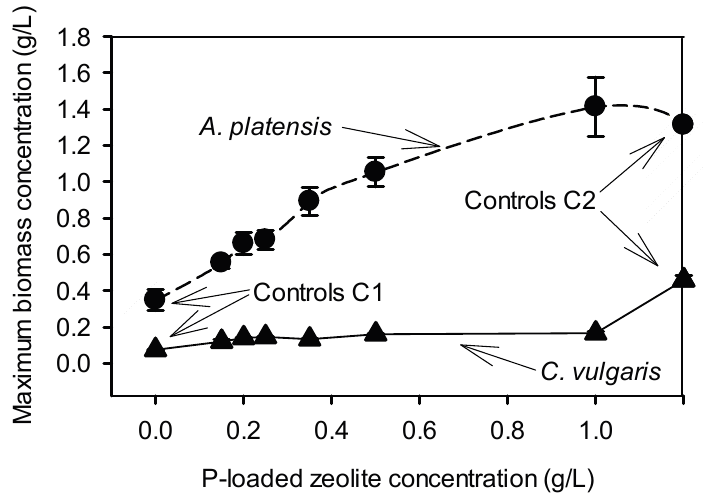
Figure 4. Relation between P-loaded zeolite concentration and maximum biomass density. Controls C1 refers to the culture grown without P-loaded zeolite and without P and controls C2 refers to those that were grown with replete P and without P-loaded